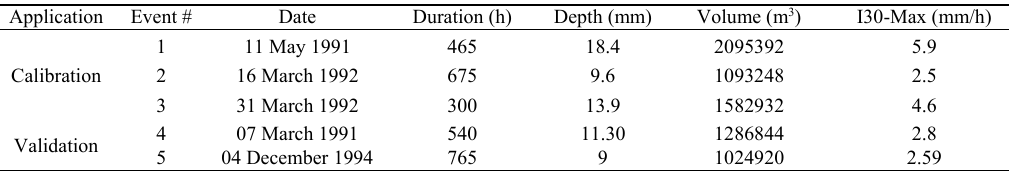
Table 1: Characteristics of chosen rainfall events